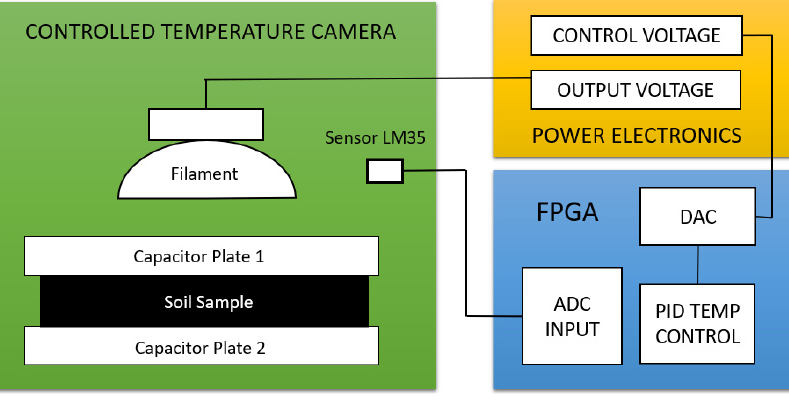
Figure 5. Integration of the controlled temperature camera.